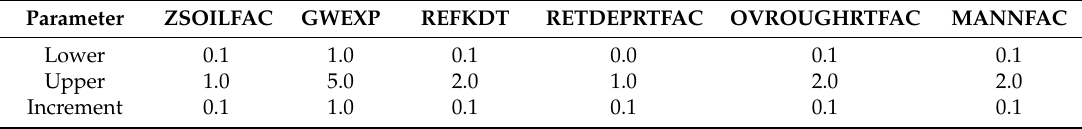
Table 5. The ranges and increments of main model parameters for the Manual Stepwise Approach. Parameter